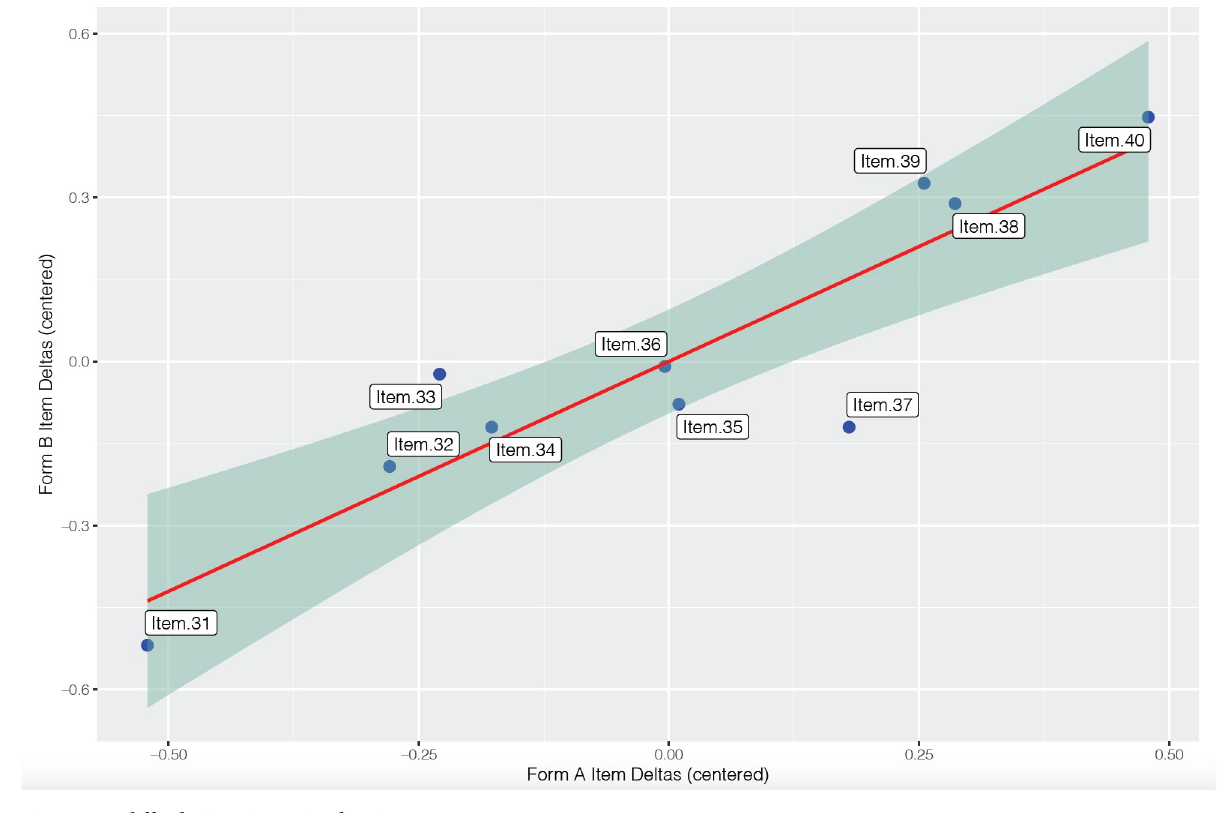
Fig 11. Item difficulty invariance visualization.